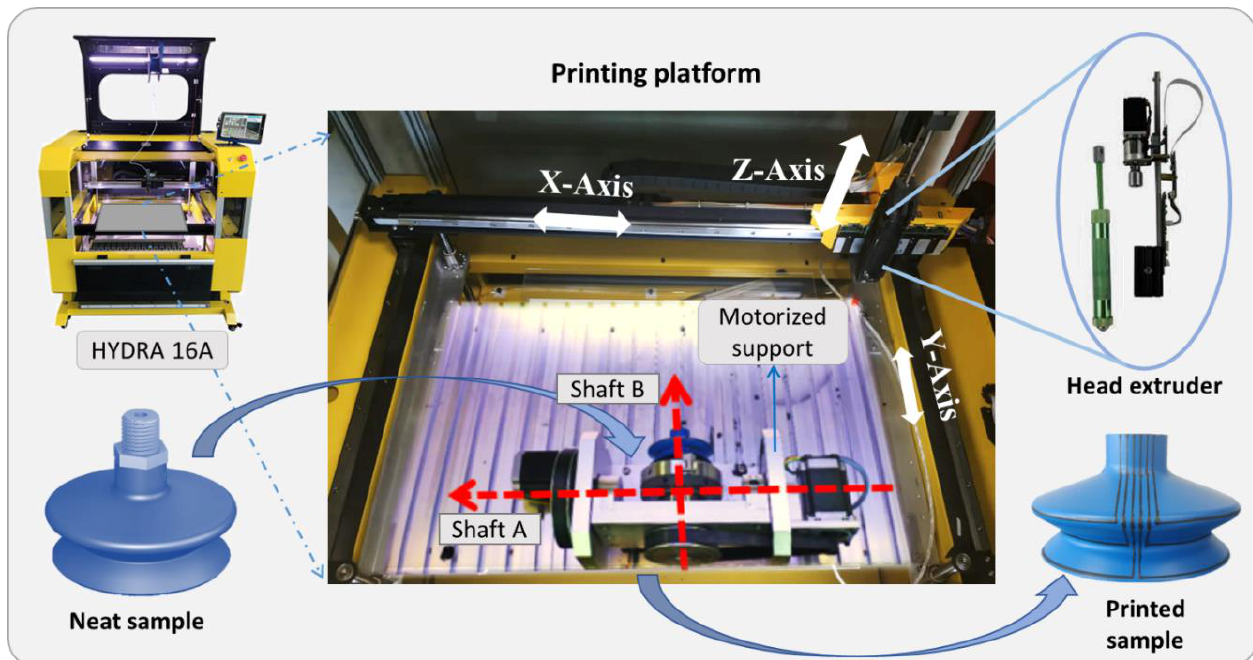
Figure 4. The printing process used to coat 3 resistive sensors on a 3D suction cup.